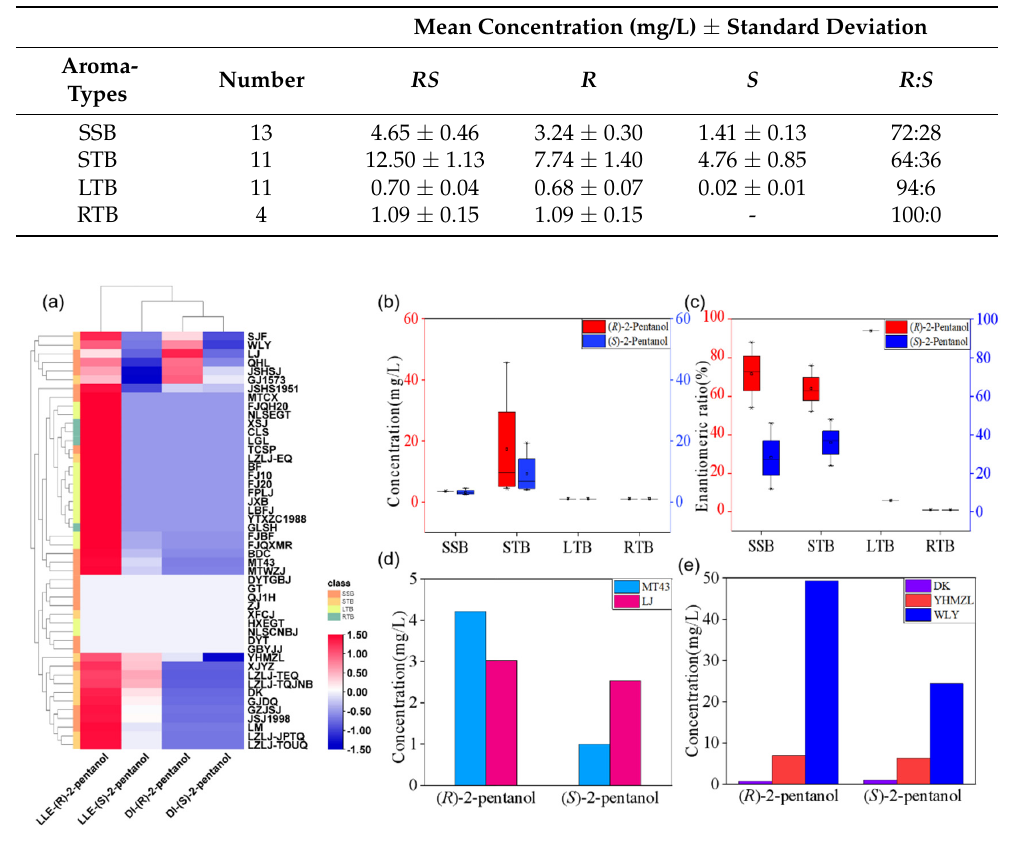
Figure 4. ( a ): 2-pentanol enantiomers concentration heat map, ( b ): Double y-axis box line plot (Red coordinates were (R) -2-pentanol, blue coordinates were (S) -2-pentanol) of 2-pentanol isomer concentration using LLE, ( c ): Double y-axis box line plot of 2-pentanol enantiomeric ratio using LLE, ( d ) Box Line plot of 2-pentanol enantiomer content in MT43 and LJ, ( e ) Box Line plot of 2-pentanol enantiomer content in DK, YHMZL, and WLY.